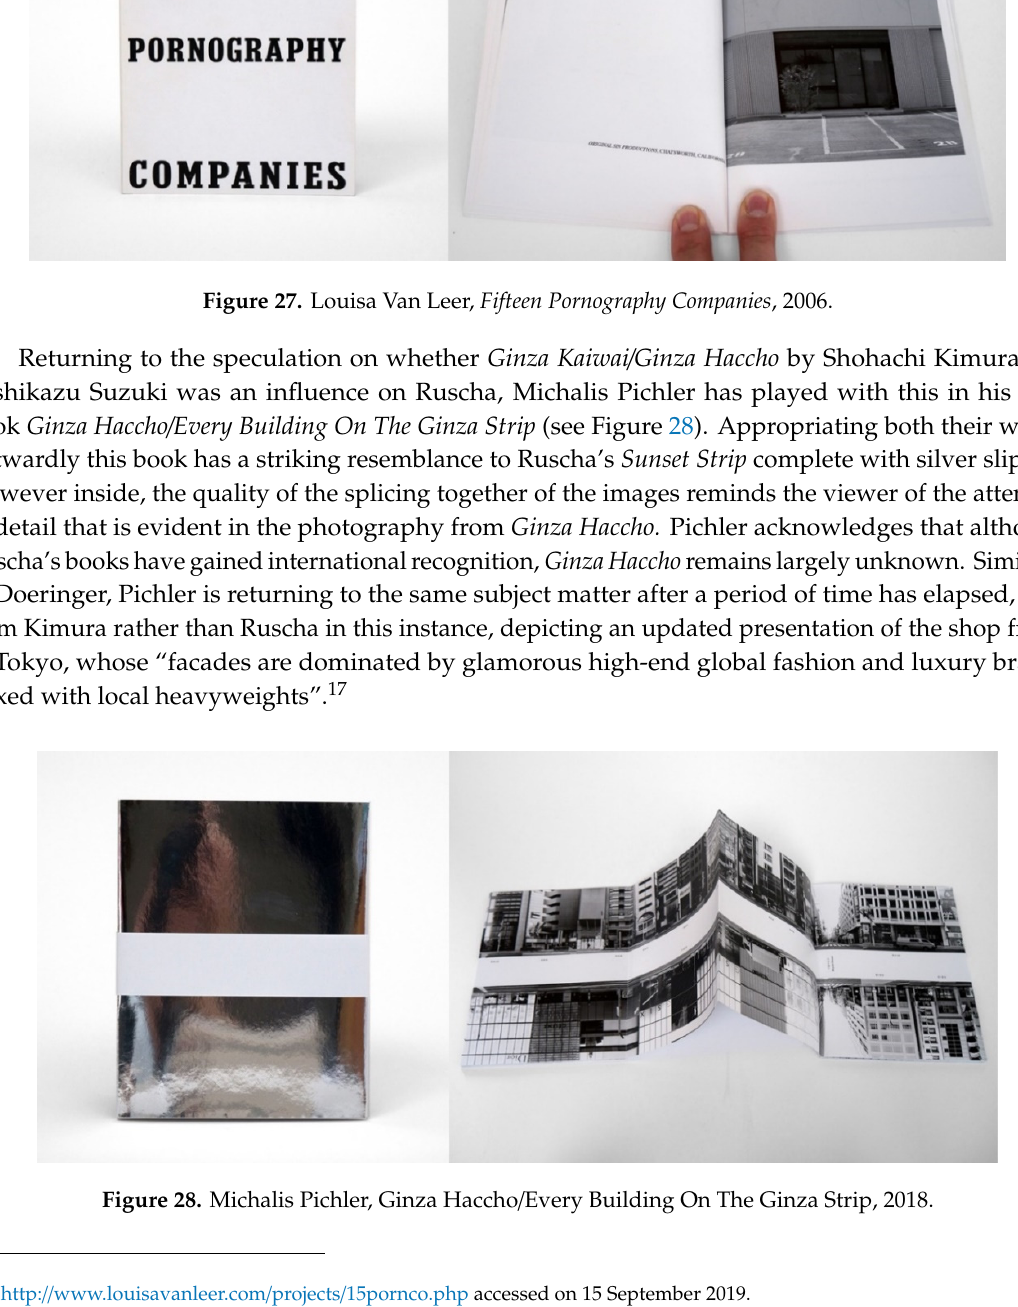
Figure 26. Doro Boehme and Eric Baskauskas, Various Blank Pages , 2009.